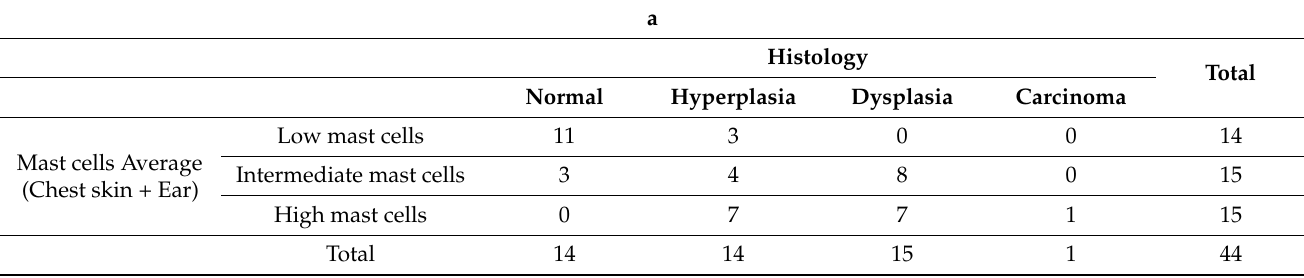
chest skin ( b ) and ear tissue ( c ) separately. Low, intermediate and high mast cell count values were